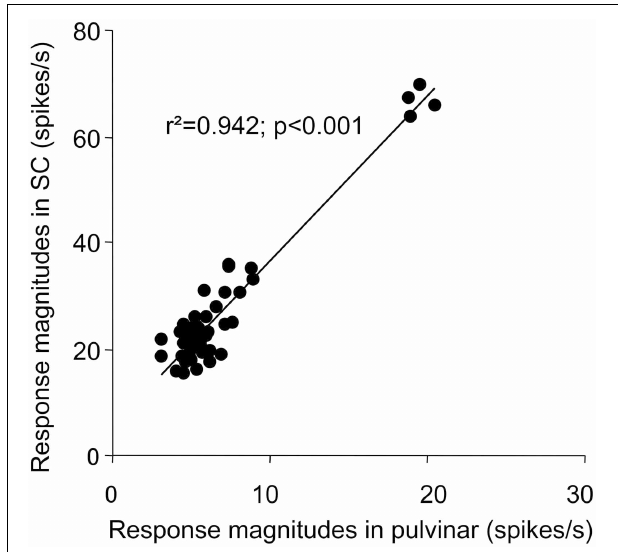
FIGURE 13 | Correlation plots between response magnitudes to the 49 stimuli in the second (25 to 50ms) epoch in sSC and those in the first epoch (0 to 50ms) in the